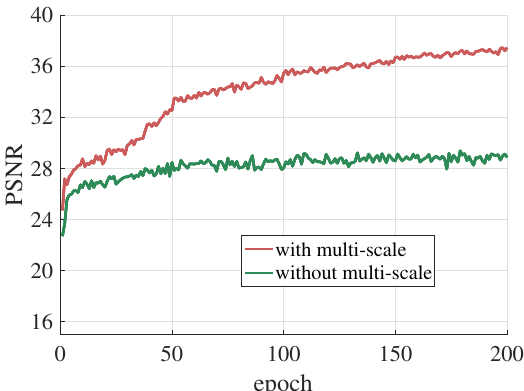
Figure 18. The PSNR comparisons of the proposed CSCNet with and without the multi-scale extension during training.